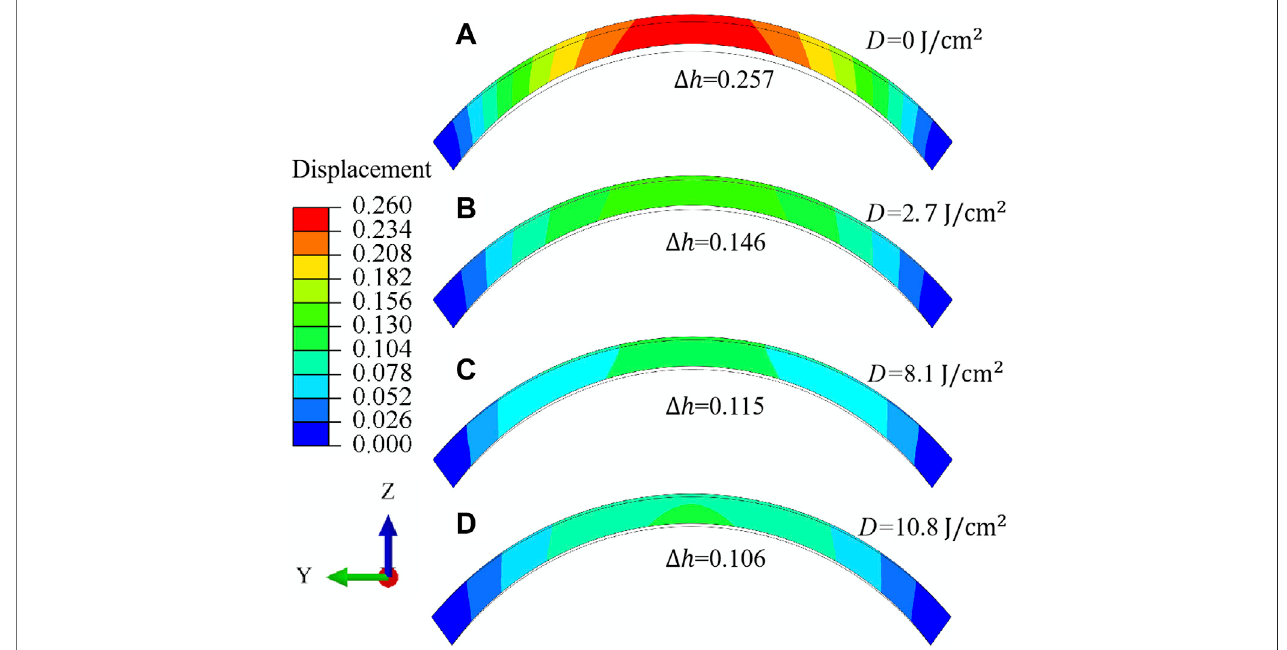
FIGURE 10 | Meridional N-T sectional view (A – D) of the displacement (unit in mm) distribution for porcine cornea when the IOP equals 30 mmHg. The irradiation dose increases from 0J/cm 2 to 10 . 8J/cm 2